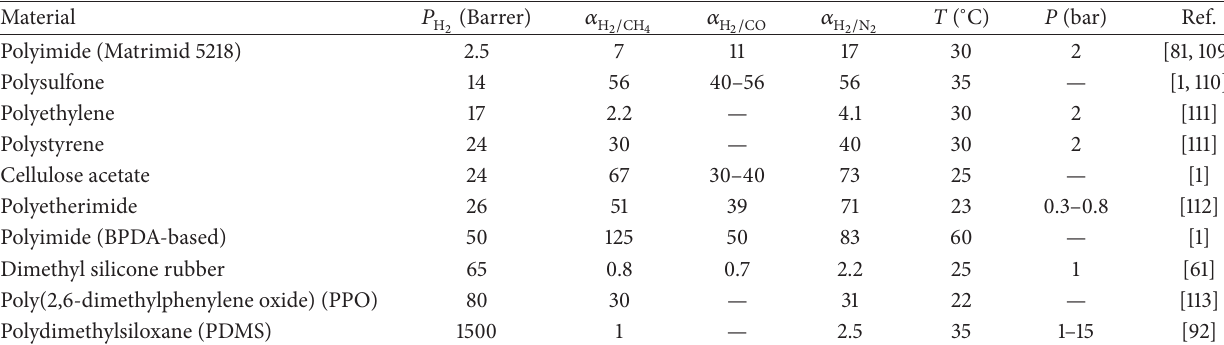
Table 7: Hydrogen permeability and selectivity of various membrane